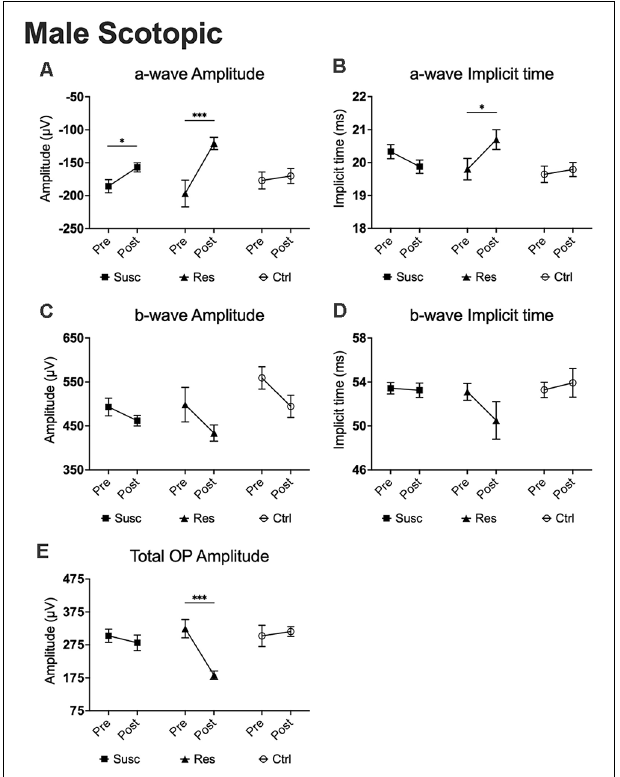
FIGURE 4 | The evolution of each ERG component under the scotopic condition at baseline and after CSDS in male mice representing the susceptible, resilient, and control male a-wave amplitude (A) , a-wave implicit time (B) , b-wave amplitude (C) , b-wave implicit time (D) , and total OP amplitude (E) . Significance was determined using linear mixed model analysis with LSD multiple comparisons test. Symbols and bars represent the group average ± SEM; ∗ p < 0.05, ∗∗∗ p < 0.001; n -values are given in the “Materials and Methods” section. FIGURE 5 | Luminance response functions comparing the post-stress ERGs